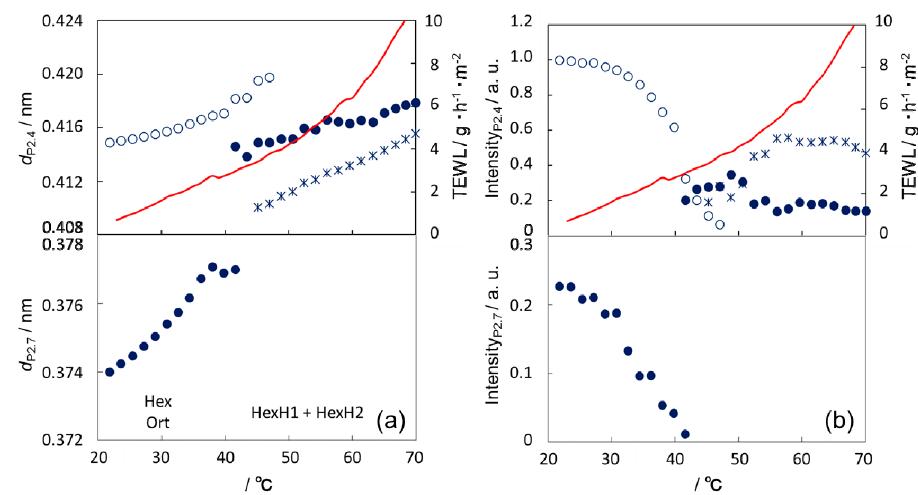
Figure 5. Comparison of TEWL with WAXD of human SC in heating. ( a ) Lattice spacings d calculated from the positions of P 2.7 ( ● ) and deconvoluted peak(s) ( ◌ , ×, and ● ) as described in Figure 4b and ( b ) their peak intensities are shown as functions of temperature, together with TEWL data shown in Figure 3b.